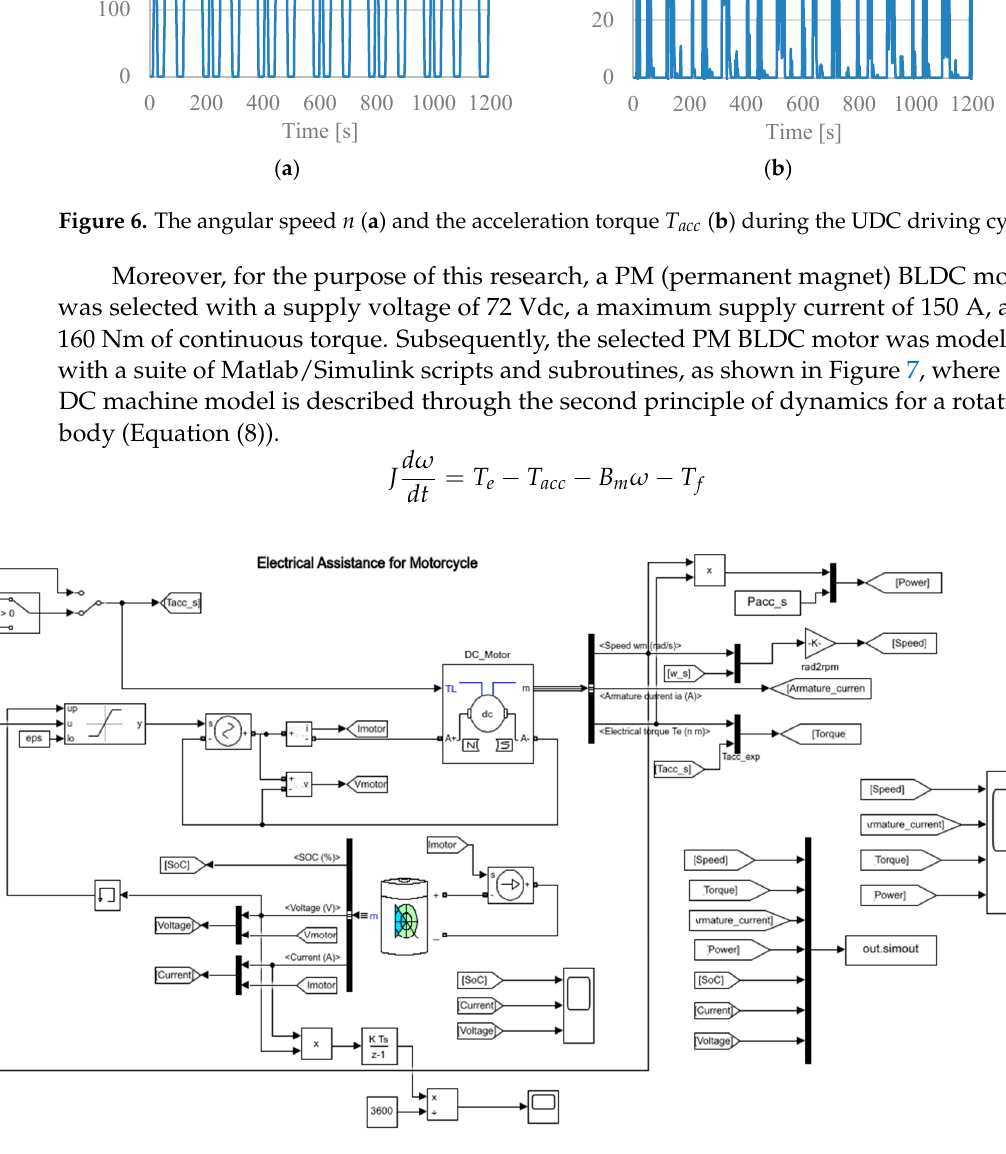
Figure 7. Electrical assistance model in Matlab Simulink.